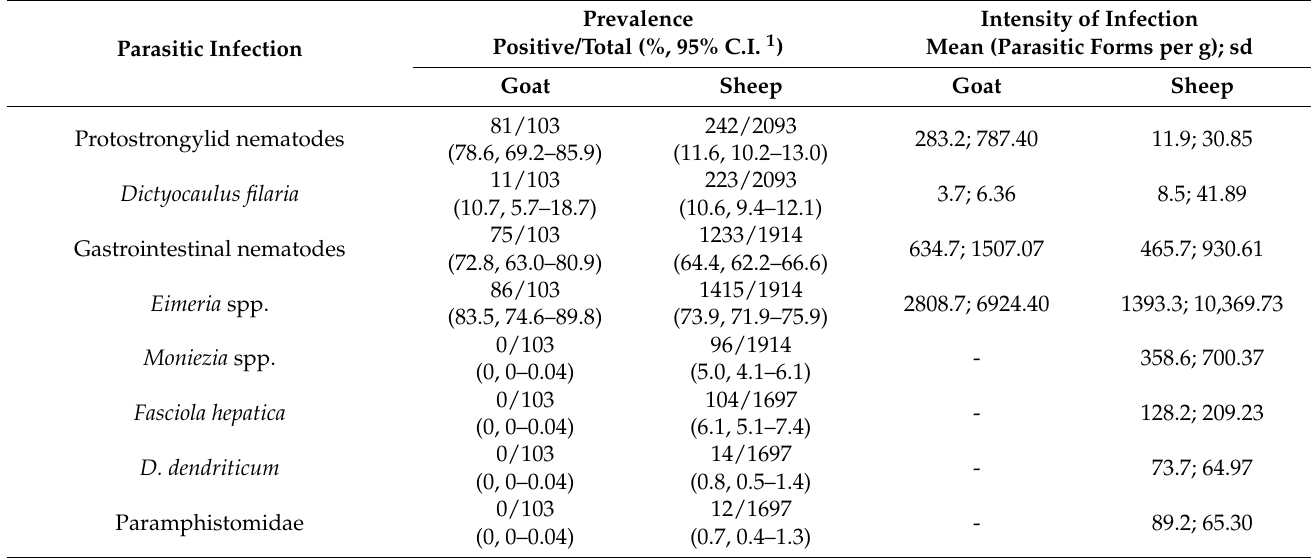
Table 1. Total prevalence and intensity of infection in sheep and goats in Galicia, NW Spain, for all parasites studied.